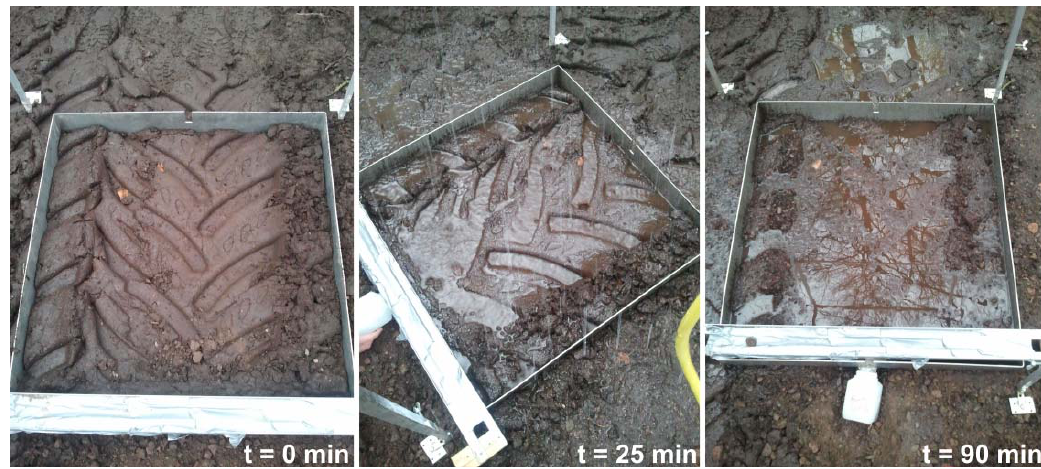
Figure 5. Successive erosion of tire imprints during rainfall simulation.